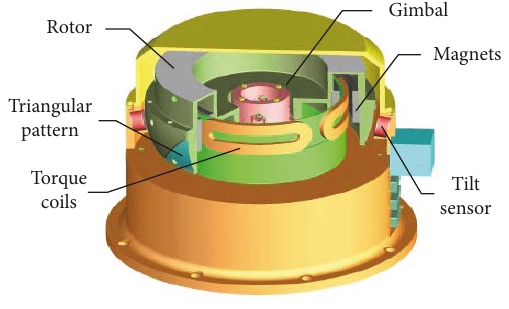
Figure 1: Cutaway view of a